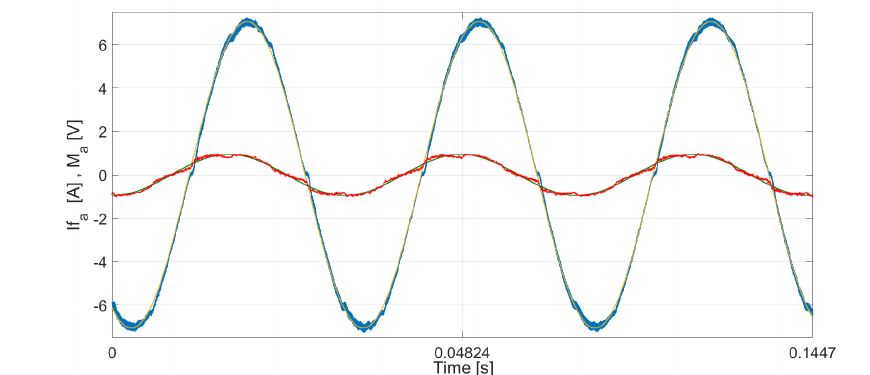
Figure 21. Measurement of the current (blue) and the corresponding modulation index (red) for a single phase. In yellow and green, the corresponding first harmonic of the waves is reported.